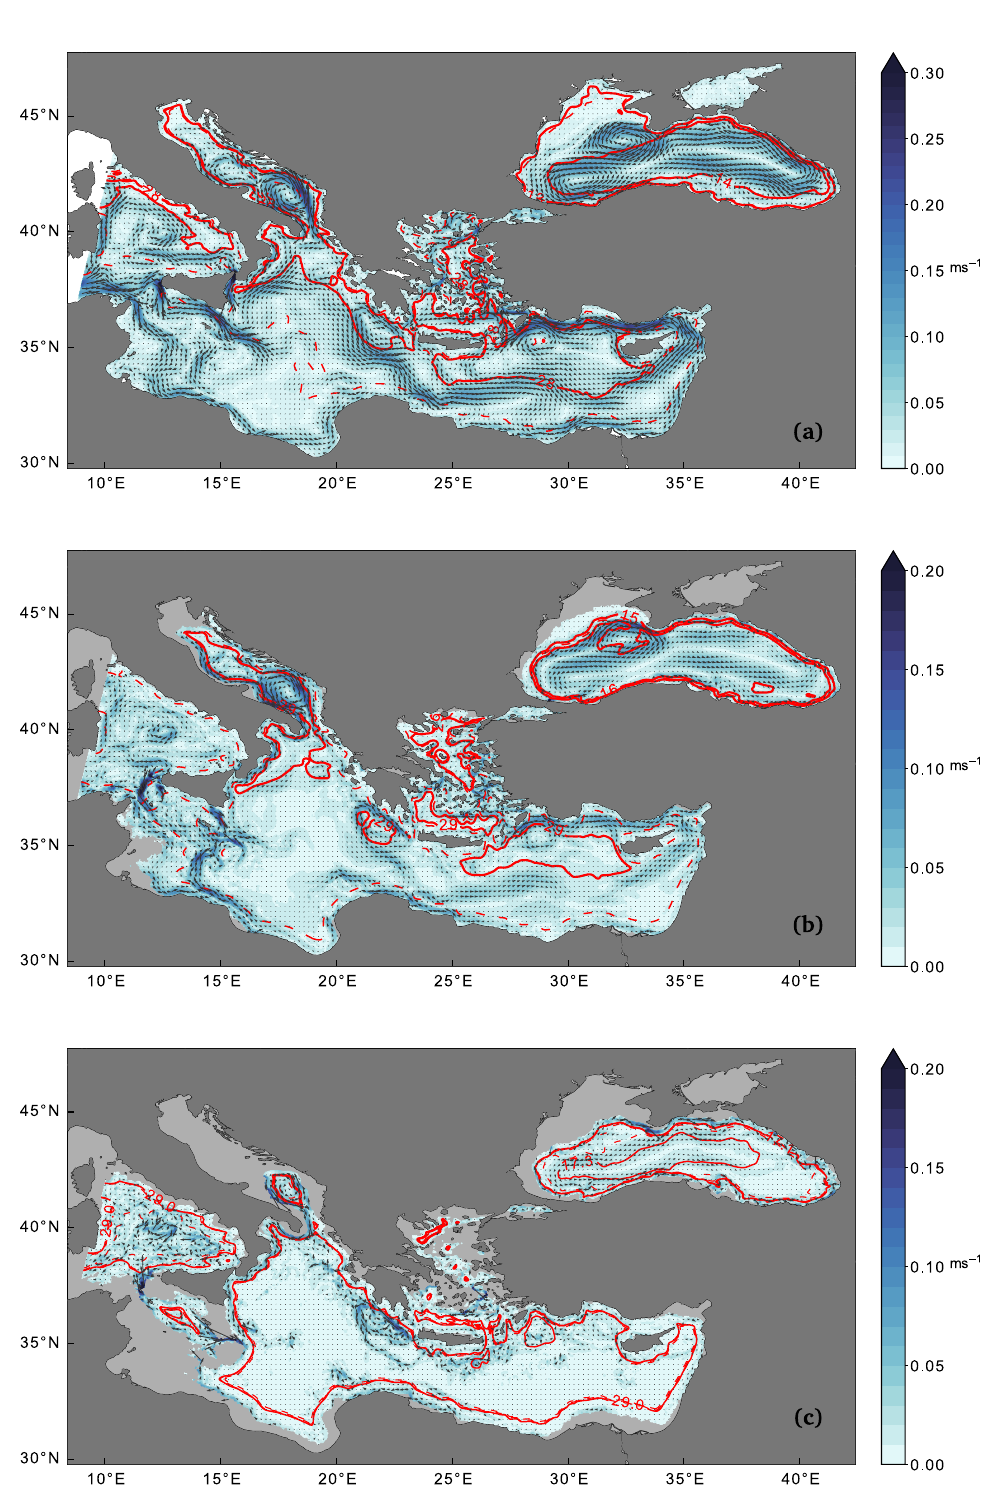
Figure 12. Currents and potential density for the period 1985–2014, vertically weight-averaged between ( a ) 0–50 m, ( b ) 50–400 m and ( c ) 400 m to maximum depth. Potential density is indicated with red contour lines. In ( a , b ), increments of 1 kg m − 3 are used for solid lines, and 0.5 kg m − 3 for dashed lines, while in ( c ), 0.2 kg m − 3 for solid lines, and 0.05 kg m − 3 for dashed